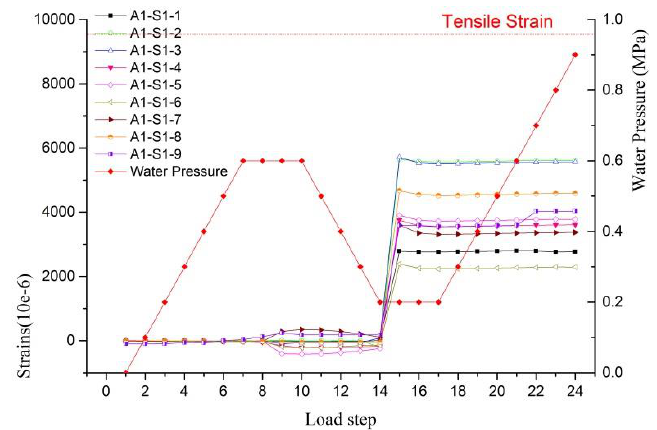
Figure 20. The strain curves of prestressed